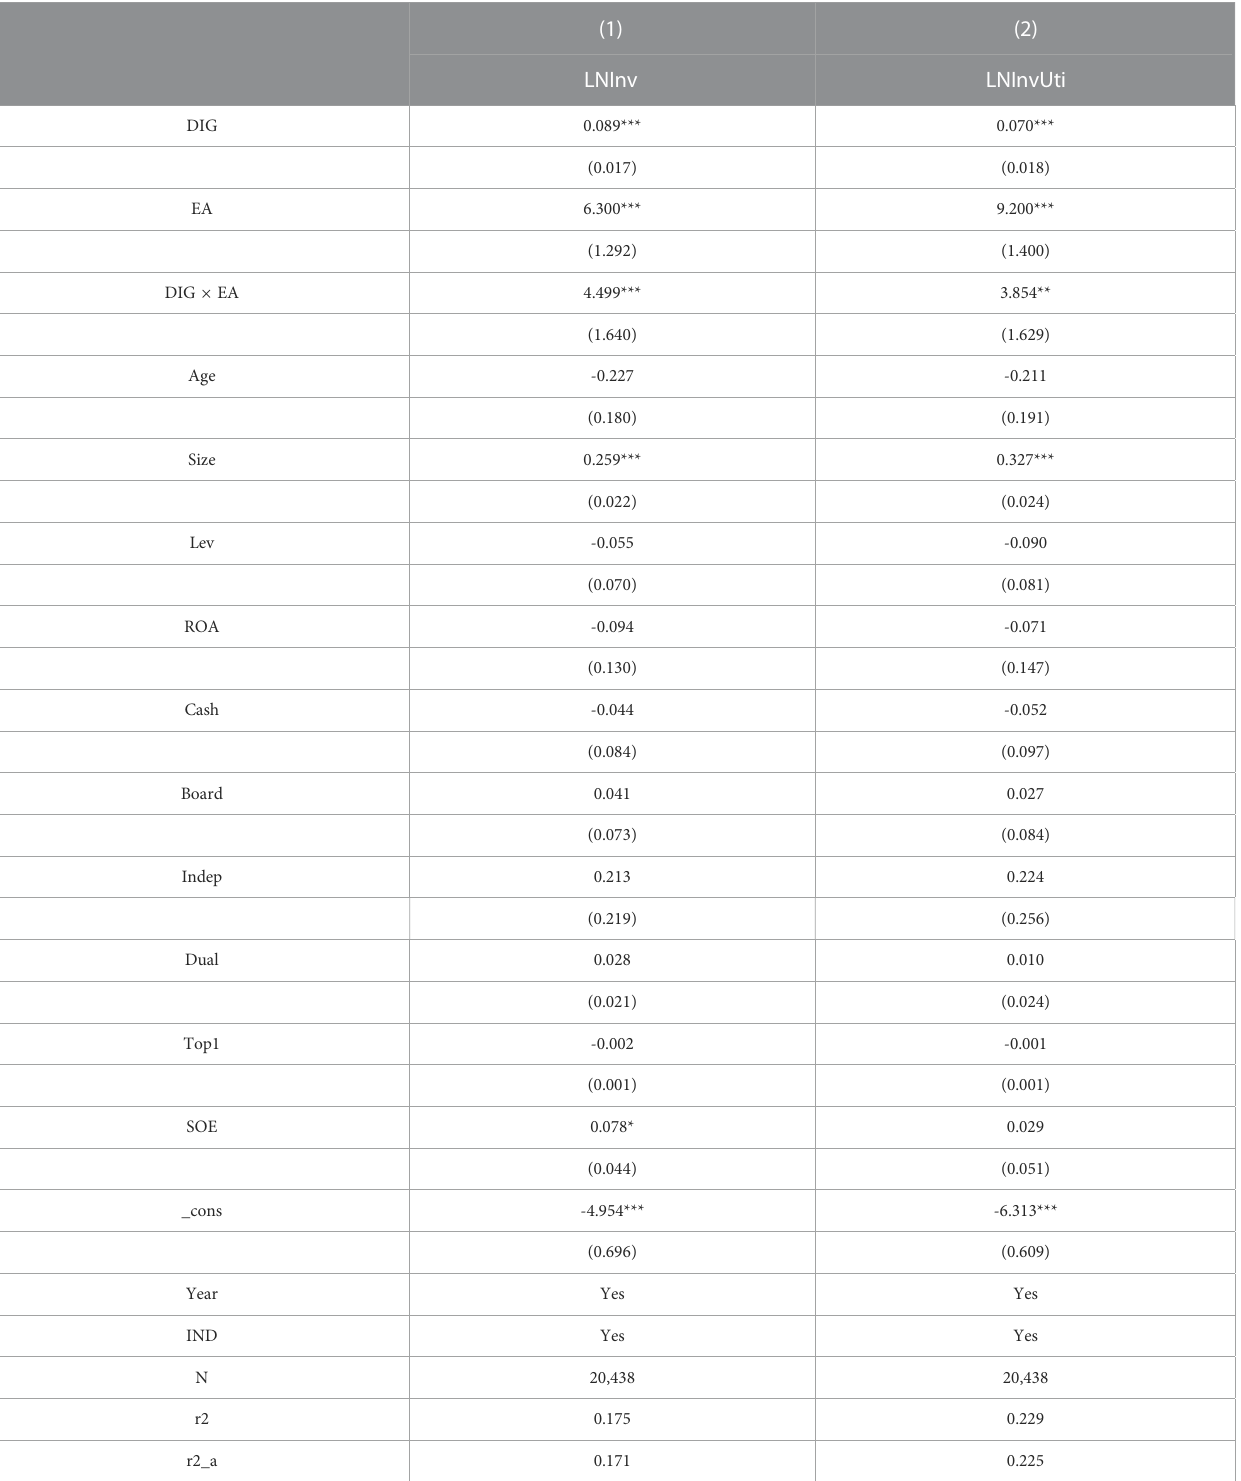
TABLE 7 Moderation effect of TMT environmental